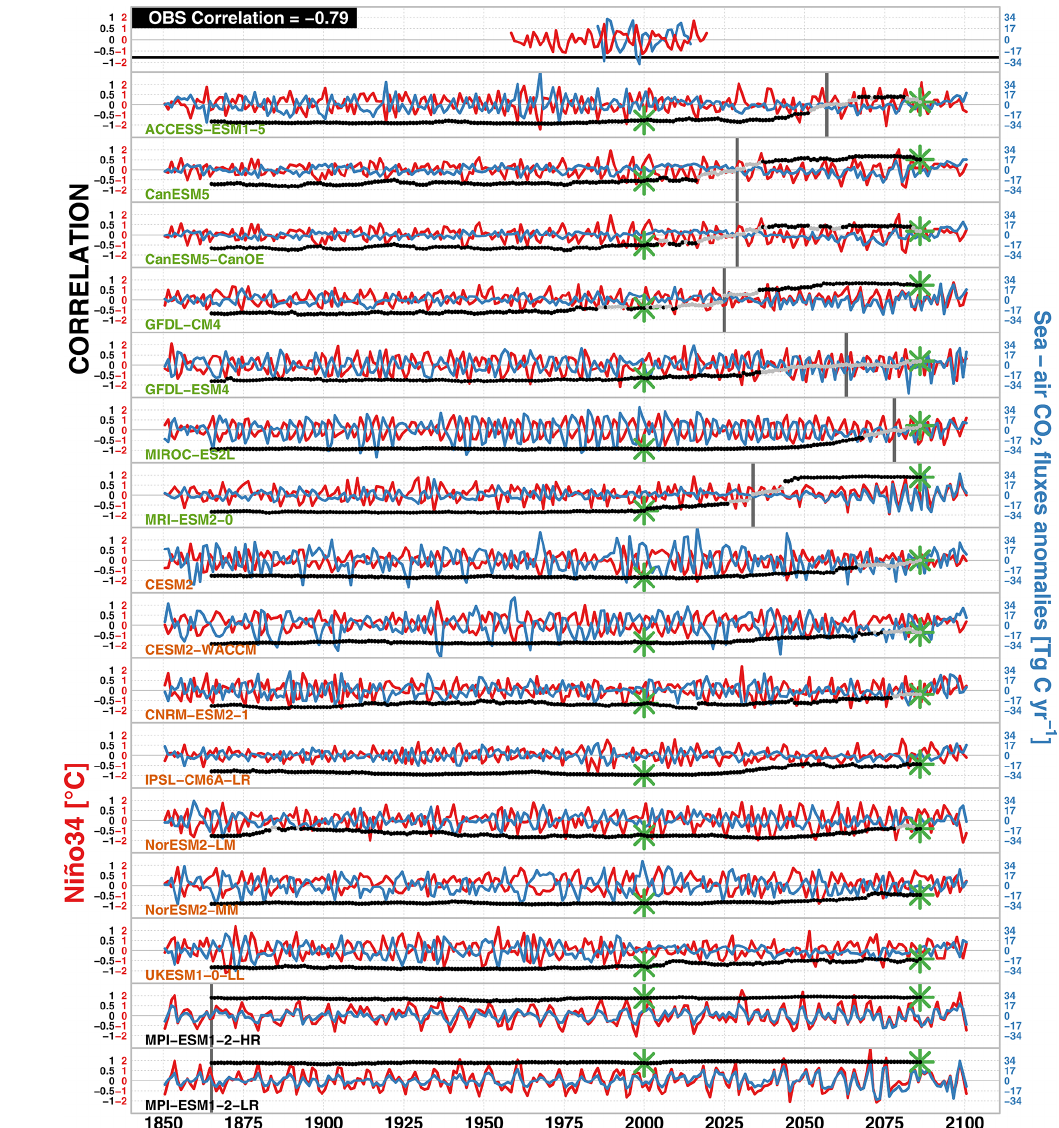
Figure 4. CMIP6 model ensemble annual time series of the Niño34 index (in ◦ C, red lines), the average CO 2 flux anomalies over the EP area (in TgCyr − 1 , blue lines), and the correlation for each 30-year moving window (significant correlations are indicated by black dots, and the non-significant ones are shown in grey). The vertical bars indicate the centre 30-year period with the first positive correlation. The first row shows the observed time series of the Niño34 index and average CO 2 fluxes anomalies over the 1985–2014. The green asterisks indicate the correlation of the models over the observed and 2071–2100 periods. Model names are given in green for the models with a shifting correlation sign, those maintaining the negative correlation are shown in orange, and those simulating positive correlation already in 1850 are shown in